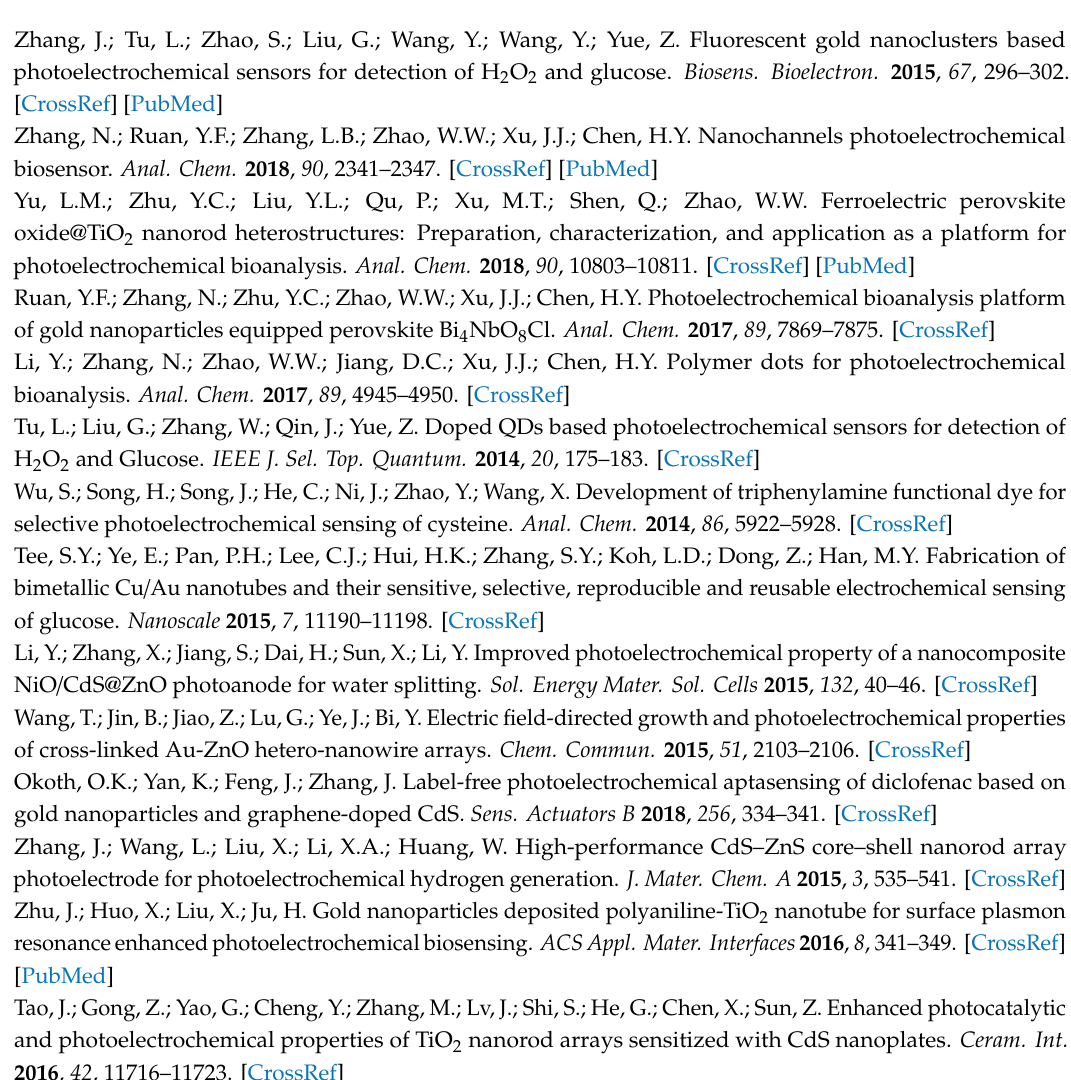
Figure S1: The curve of Pt-IrO 2 / TiO 2 NTs / Ti (after 30 days) for the detection of di ff erent concentrations for GSH. Author Contributions: All authors have participated actively in the development of this work. J.T. and B.Z. conceived and designed the experiments; J.T. performed the experiments; J.T., Z.Y., S.Z. (Shoumin Zhang), W.H., and B.Z. analyzed the data; P.Z. contributed analysis tools; S.Z. (Shasha Zhang), G.H., and Z.S. contributed reagents; J.T. wrote the paper. All authors have read and agreed to the published version of the manuscript. and